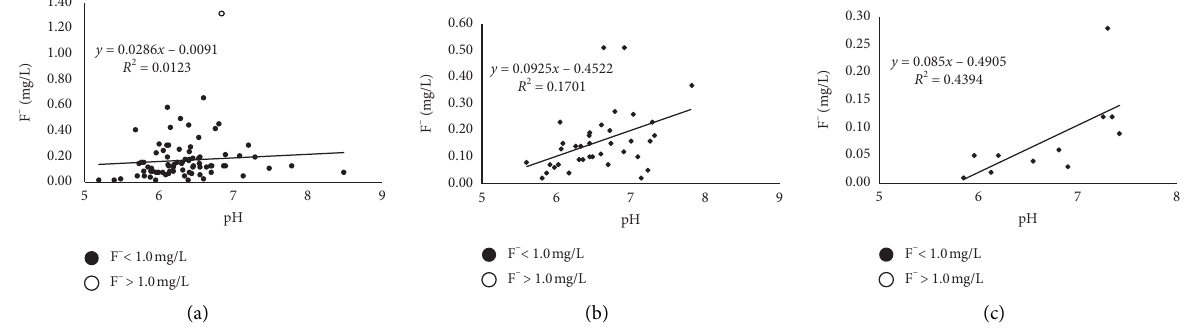
Figure 4: Relationship between F − and pH in the groundwater of different subsystems. (a) Groundwater subsystem of Suishui River. (b)